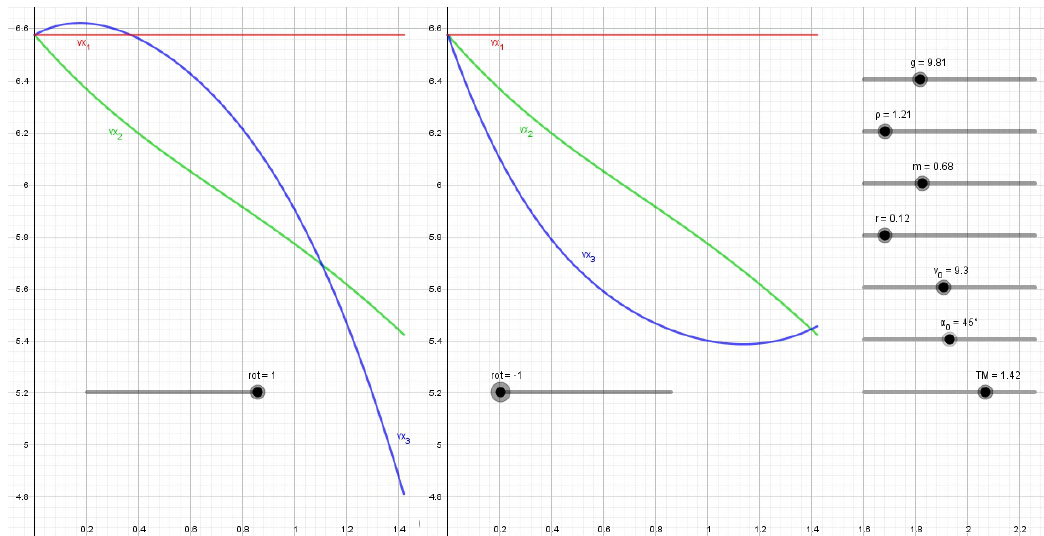
Figure 28: Presentation of paper [51].